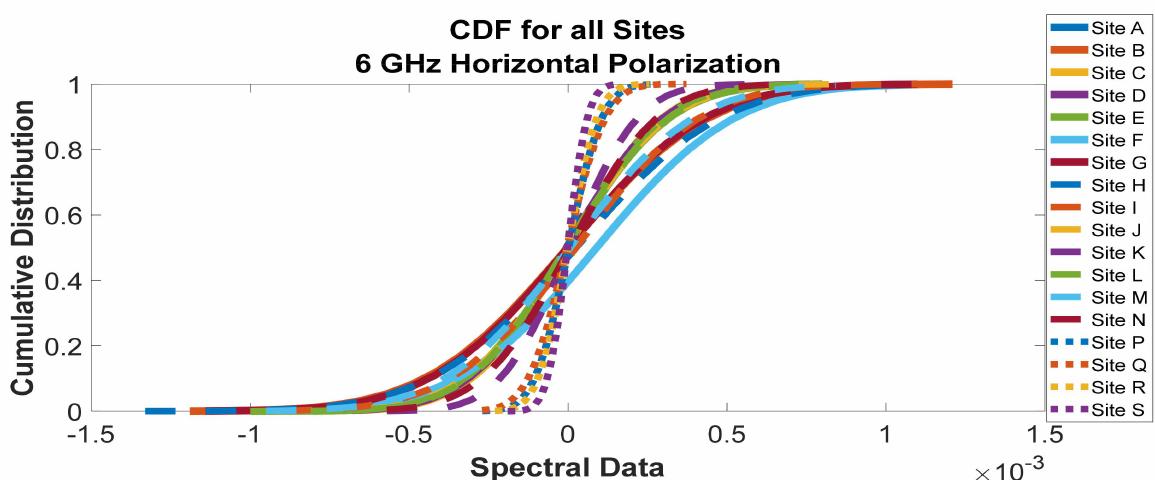
Figure 35. Cumulative distribution functions of frequency scan for all sites at 6 GHz horizontal polarization.